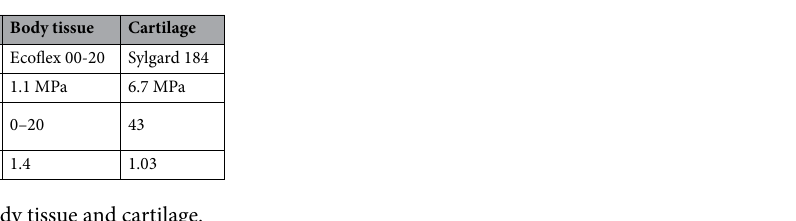
Table 2. Details of body tissue and cartilage.